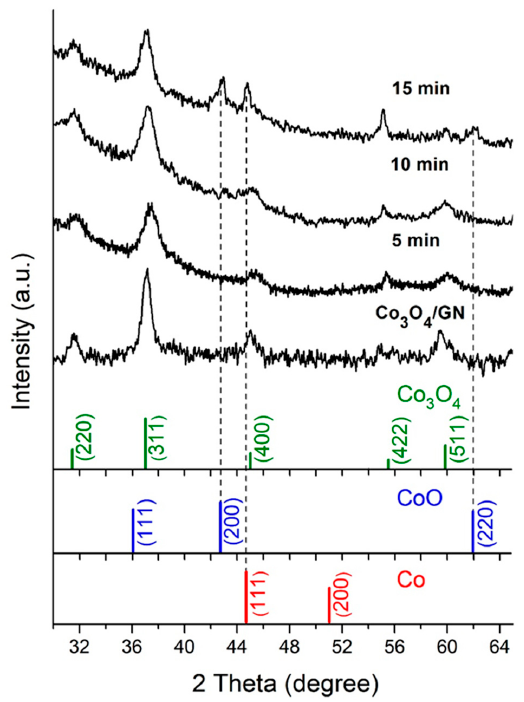
Figure 1. The XRD patterns of as-synthesized Co 3 O 4 nanoparticles and after hydrogen reduction treatment at 350 °C in 5%H 2 -95%Ar for 5, 10, and 15 min, respectively. The standard materials of cubic Co 3 O 4 (JCPDS: 073–1701), fcc Co (JCPDS: 89–7093), and cubic CoO (JCPDS: 70–2855) are also shown.